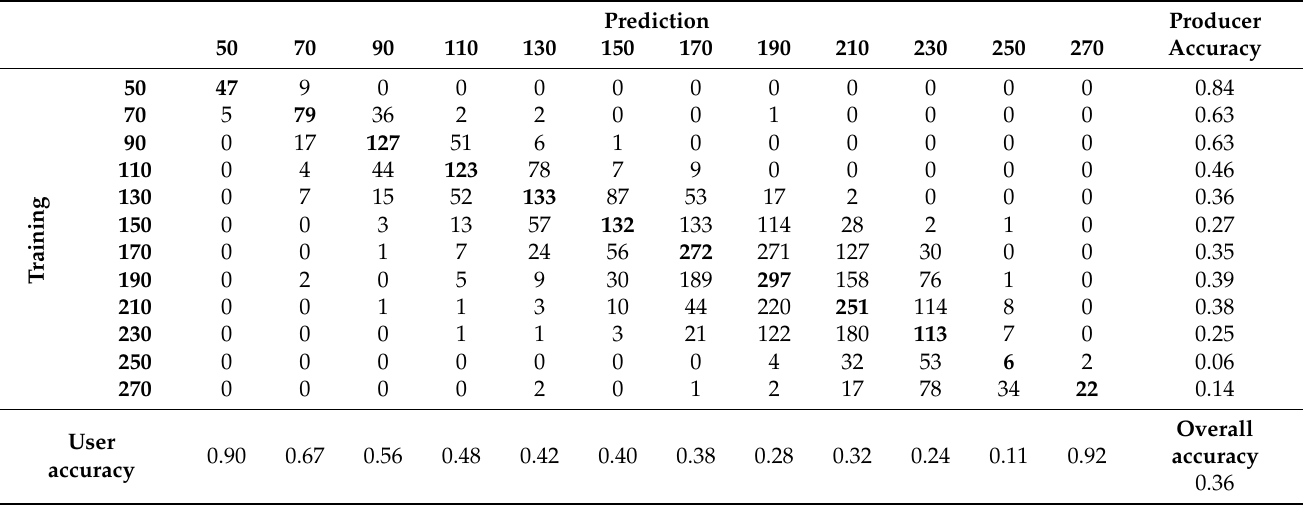
Table 7. Species-specific SSD accuracies computed by species class for the NN training dataset.